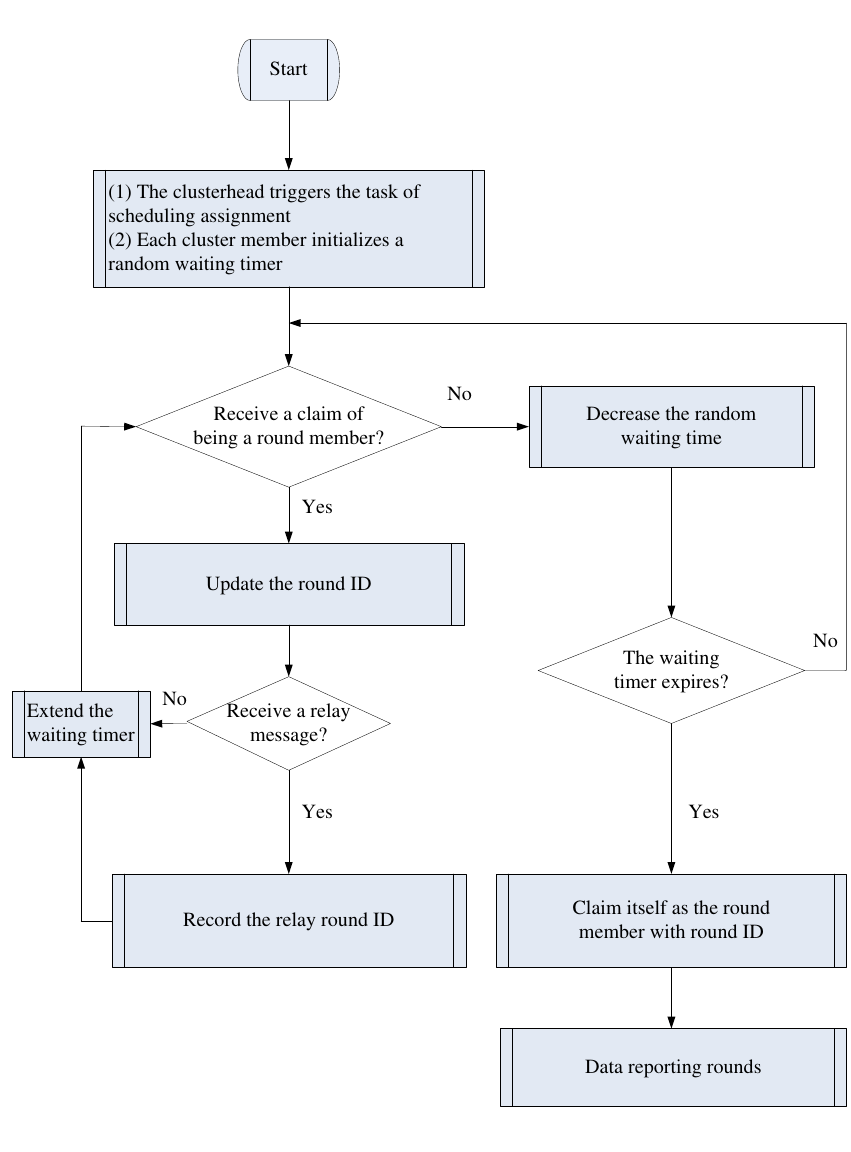
Figure 3. Virtual sensor scheduling flowchart for the DASA